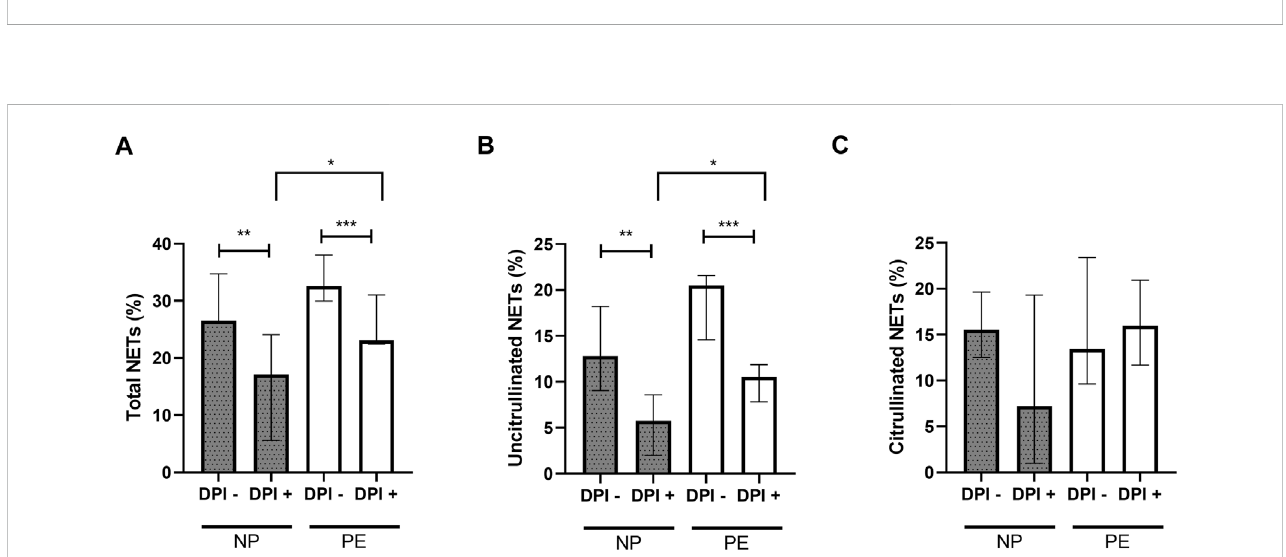
FIGURE 4 Comparisons of the percentages of total NETs (A) and uncitrullinated NETs (B) formed after stimulation of healthy volunteer neutrophils with plasma from women delivering normal pregnancies (NP) or preeclampsia (PE) with and without inhibition by DPI. (A) NP without DPI 26.54% [25.48; 34.70]; NP with DPI 17.12% [5.86; 24.08]. PE without DPI 32.57% [29.99; 38.01]; PE with DPI 23.08% [22.44; 31.03]. (B) NP without DPI 12.80% [9.05; 18.23], NP with DPI 5.76% [1.98; 8.60].PE without DPI20.49% [14.58;21.58];PE withDPI10.54%[7.83; 11.87]. (C) NPwithoutDPI15.56% [12.52; 19.63], NPwith DPI7.21% [1;19.30]. PE without DPI 13.44% [9.63; 23.40]; PE with DPI 16.01% [11.68; 20.93]. DPI-: without inhibition by DPI; DPI+: with inhibition by DPI. Results are represented with their medians and interquartile ranges [Q1; Q3]. DPI: diphenyleiodonium. The Bonferroni correction with a cut-off at 0.025 was applied to take into account the multiplicity of tests. * p < 0.025, ** p < 0.01, *** p <